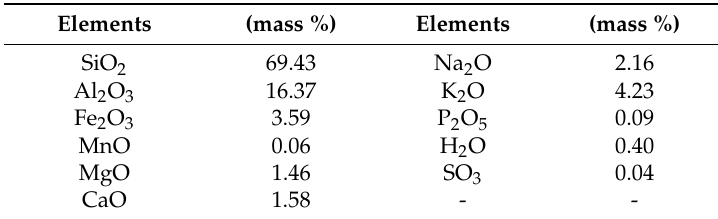
Figure 2. X-ray diffraction (XRD) patterns of topsoil in the coal mine in Indonesia and simulated topsoil: M, I, K, Q, and A represent Montmorillonite, Illite, Kaolinite, Quartz, and Albite, respectively. Table 2. Chemical composition of the simulated